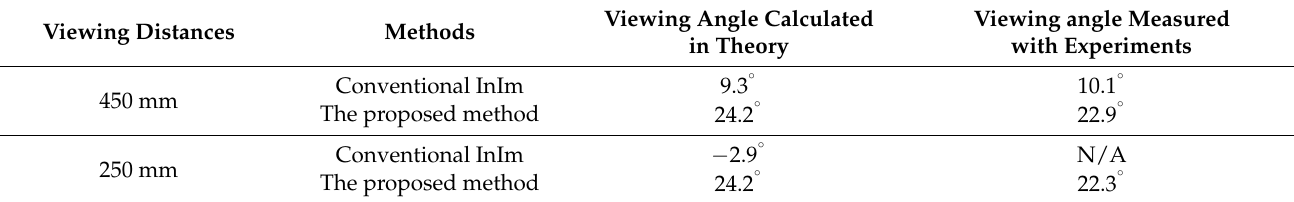
Table 2. Comparisons of the viewing angles.